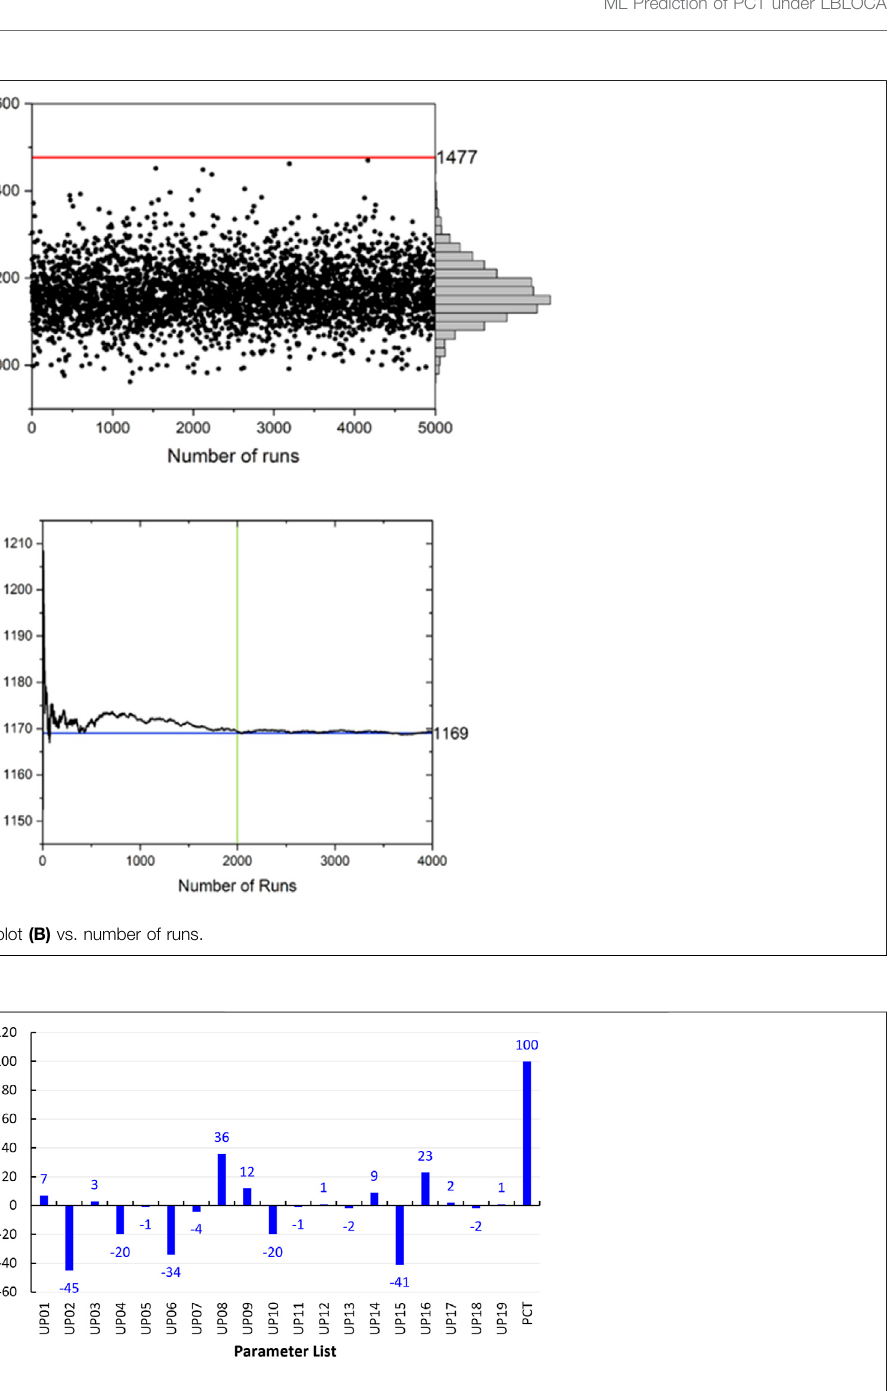
FIGURE 4 | Spearman ’ s correlation